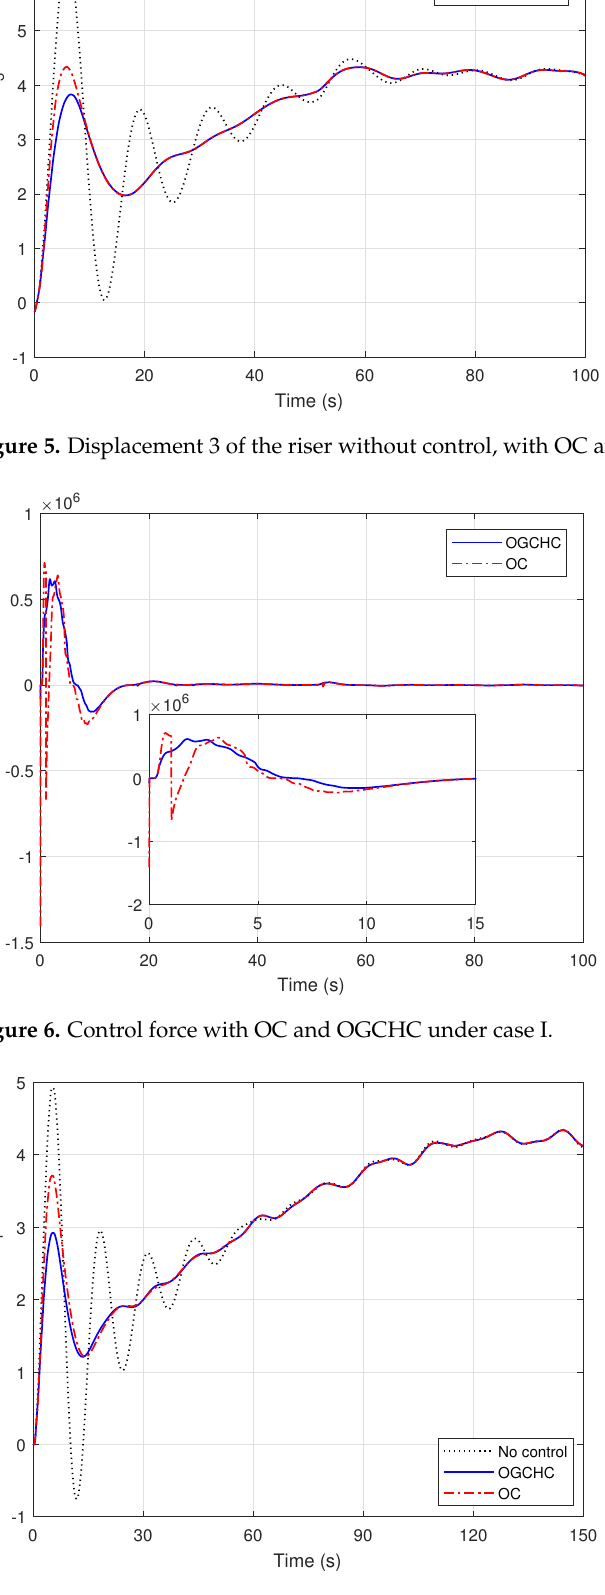
Figure 7. Displacement 1 of the riser without control, with OC and OGCHC under case